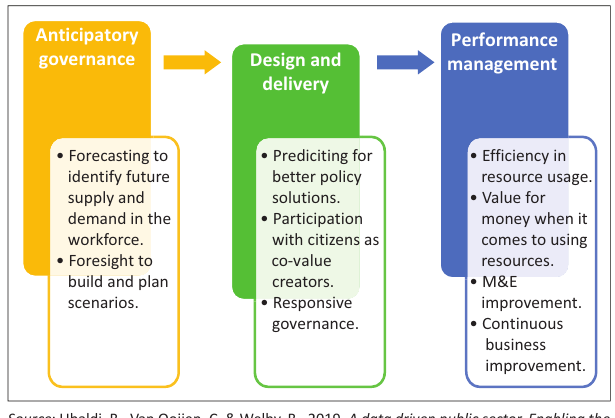
FIGURE 4: Opportunities for big data usage in the South African human resource